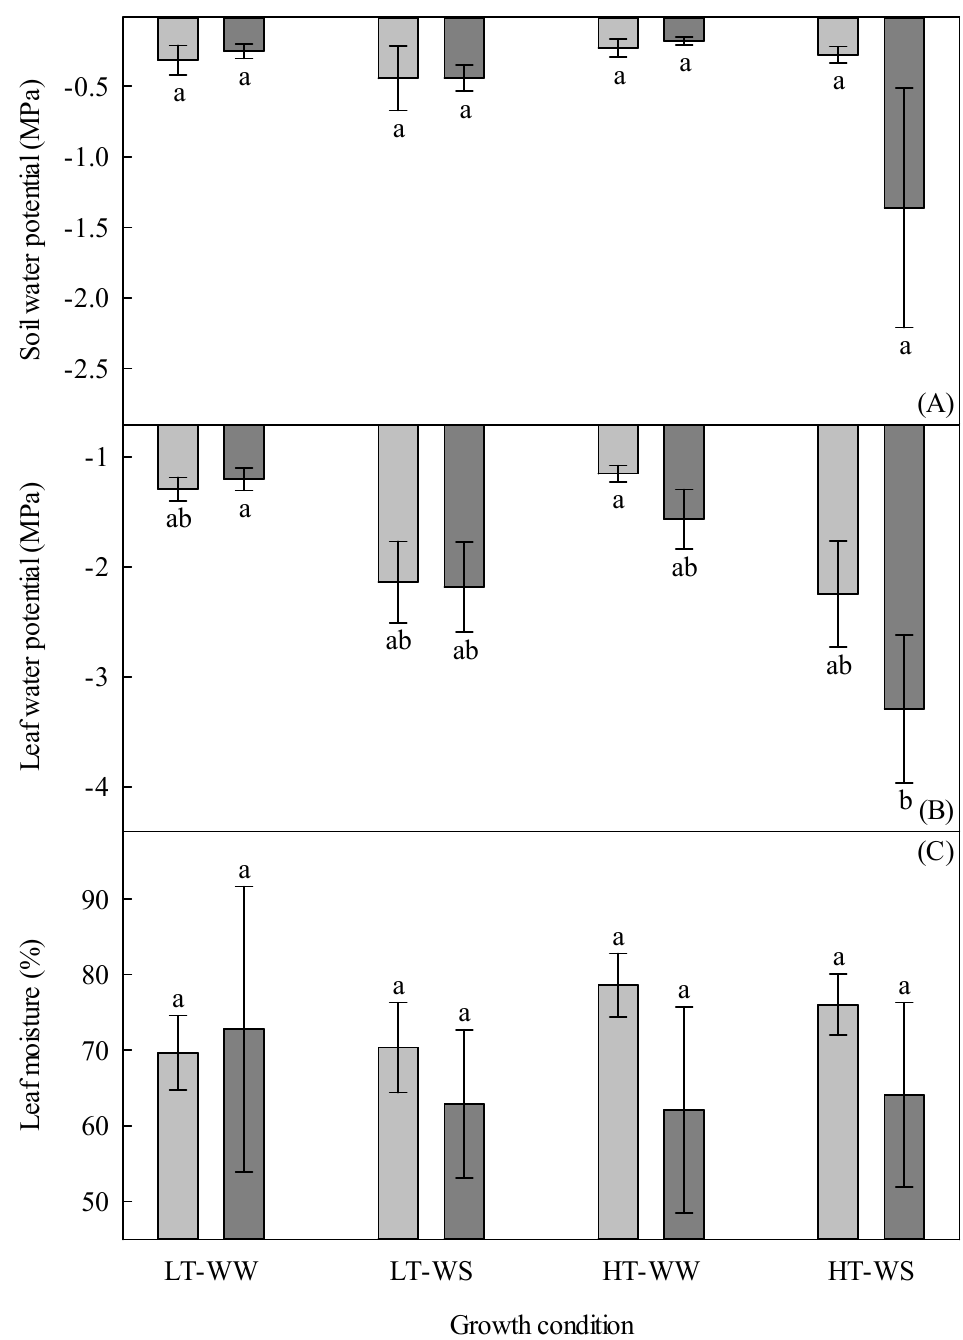
Figure 6. Water potential and leaf moisture of 33-day-old tomato plants grown under eight exper- imental conditions, including two temperature regimes, two watering regimes, and two abscisic acid concentration applications after 12 days of initial germination and growth in growth chambers with lower temperature, watering to field capacity, and without abscisic acid application. ( A ) Soil water potential, ( B ) leaf water potential, and ( C ) leaf moisture. LT, lower temperature; HT, higher temperature; WW, well-watered; WS, water stressed; light gray, no abscisic acid; dark gray, abscisic acid. Data are the means ± SE of 72 samples (leaf and soil water potential) from three experiments and 48 samples (leaf moisture) from two experiments. Bars with different letters above or below them are significantly different according to Scheff é ’s multiple comparison procedure at the 5% confidence